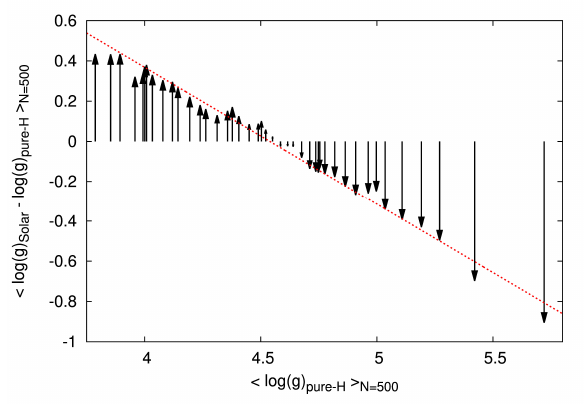
Figure 3. Shift in log g with the addition of metals in solar abun- dances as a function of the log g given by the pure-H models. Val- ues were averaged over 500 objects sorted by log g . The shifts are well described by a linear fit ∆ log g = −0.68(0.01) log g pure-H + 3.10(0.06), shown as a red dashed line. The pure-H values are almost 1.0 dex higher than the solar abundance values above log g = 5.5. This is a similar result to the obtained by Brown et al. (2017) when when fitting pure hydrogen model to synthetic main- sequence spectra.